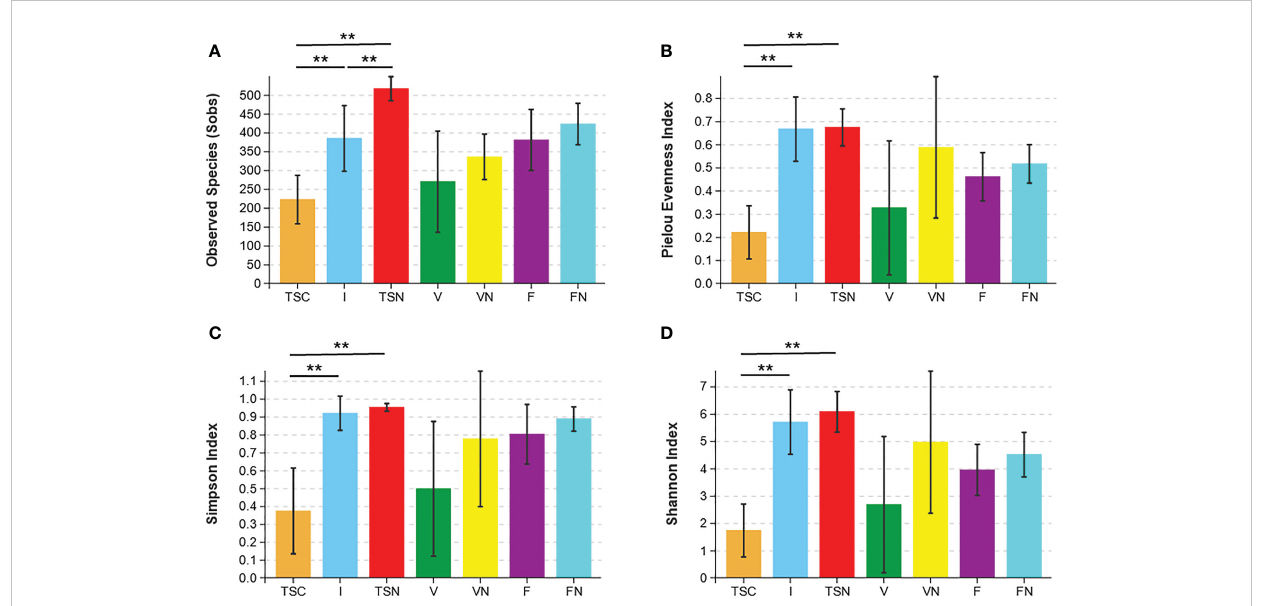
FIGURE 1 Microbial alpha diversity indices. The ecological diversity of microbiota in transitional stools of newborns (36-72h after birth), virginal fl uids (before delivery) and stool of mothers (the last excretion before delivery) was measured by Sobs (A) , Pielou evenness index (B) , the Simpson index (C) , and the Shannon index (D) . The P values were conducted by Welch ’ s t test. Statistical signi fi cance is displayed as * P <0.05 and ** P <0.01. Sobs, Observed species; TSC, Transitional stools of caesarean delivered neonates; I, Transitional stools of caesarean delivered neonates with the treatment of swabbing maternal vaginal fl uid; TSN, Transitional stools of natural delivered neonates; V, Vaginal fl uids of the pregnant women who underwent caesarean delivery; VN, Vaginal fl uids of the pregnant women who underwent natural delivery; F, Feces of the pregnant women who underwent caesarean delivery; FN, Feces of the women who underwent natural delivery. Symbol "*" was presented above each